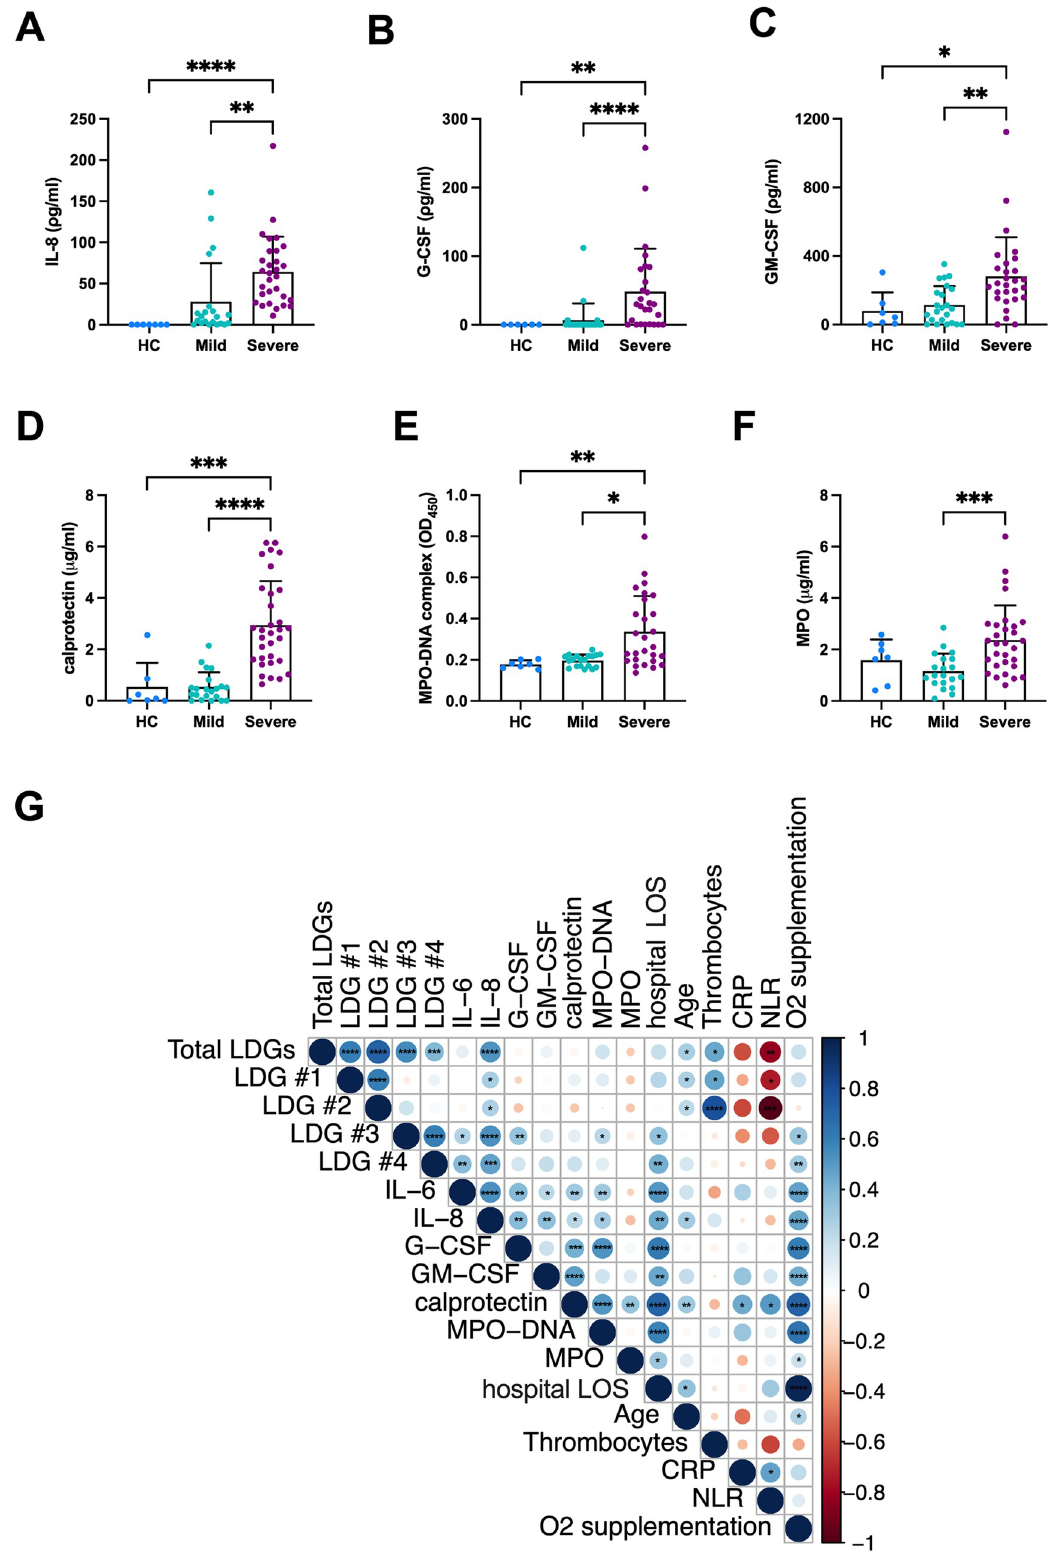
Fig 3. The increased amounts of COVID-19 LDG subsets are linked to elevated recruitment and activation of granulocytes. (A-F) The serum concentrations of IL-8, G-CSF, GM-CSF, calprotectin, MPO-DNA complexes and MPO in mild and severe acute COVID-19 as well as HC were measured by enzyme-linked immunosorbent assays. The dates of serum sampling matched those